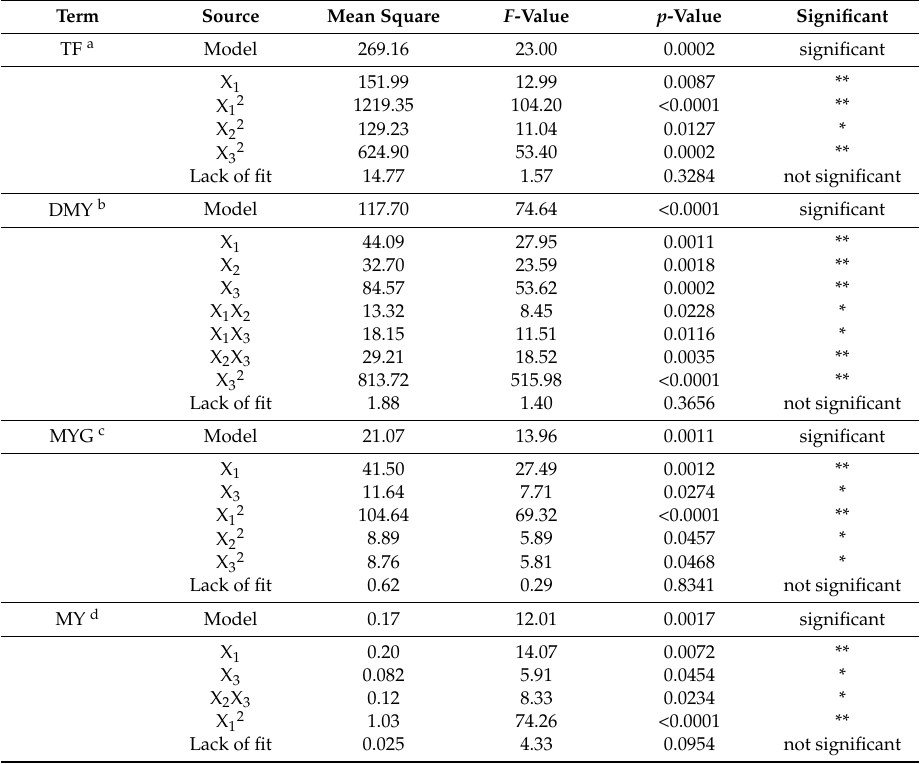
Table 2. ANOVA statistics of quadratic models for the extraction yields of the total flavonoids (TF), dihydromyricetin (DMY), myricitrin (MYG) and myricetin (MY) from A. grossedentata leaves. Term Source Mean